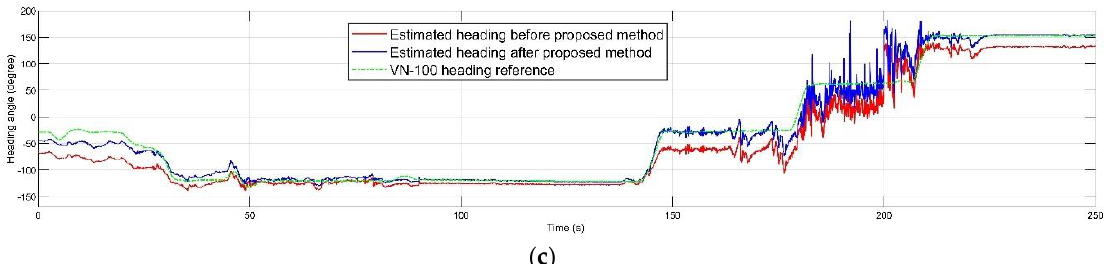
Figure 8. Estimated orientation before and after performing the propsed method compared to the true reference orientation: ( a ) roll; ( b ) pitch; ( c ) heading.